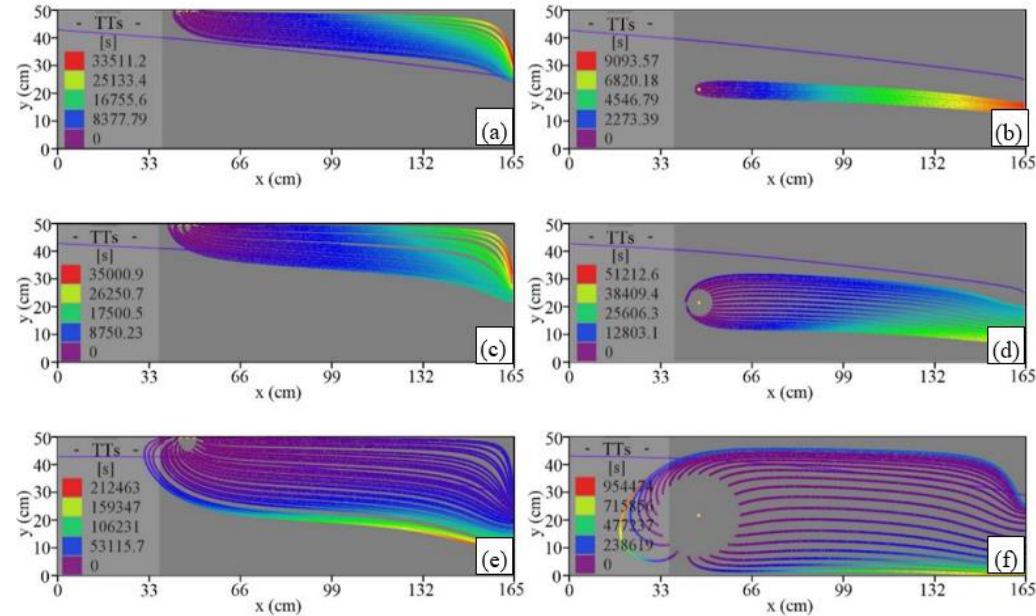
Figure 16. Artificially recharged water lens associated with travel times (TTs) produced by the infiltration basin (left panel of the figures) and injection well IW3 (right panel of the figures) with different depth-decay exponents. The depth-decay exponents in ( a ) and ( b ) were set to 0.01 m −1 . The depth-decay exponents in ( c ) and ( d ) were set to 0.05 m −1 . The depth- decay exponents in ( e ) and ( f ) were set to 0.1 m −1 . The blue lines in the figures represent the water table. The yellow points in the figures are the locations of injection wells. The red lines are flow paths of artificially recharged water. The rainbow lines are flow paths of artificially recharged water. Water 2021 , 13 , x FOR PEER REVIEW